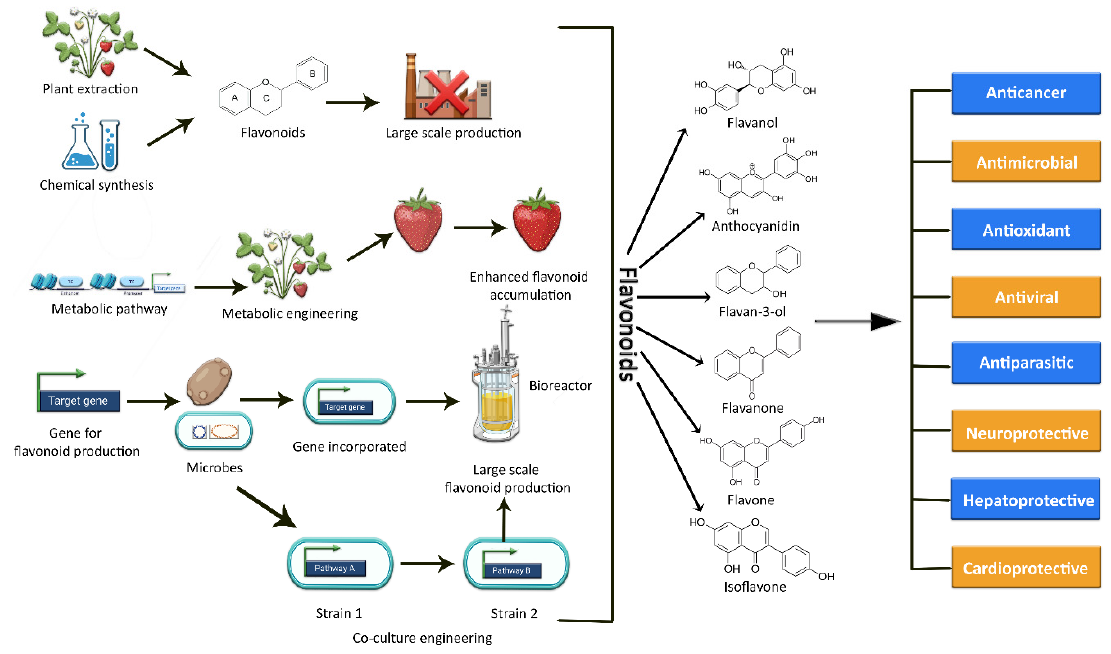
Figure 1. Graphical representation of the various methods used to synthesize a variety of flavonoids, as well as their potential biological